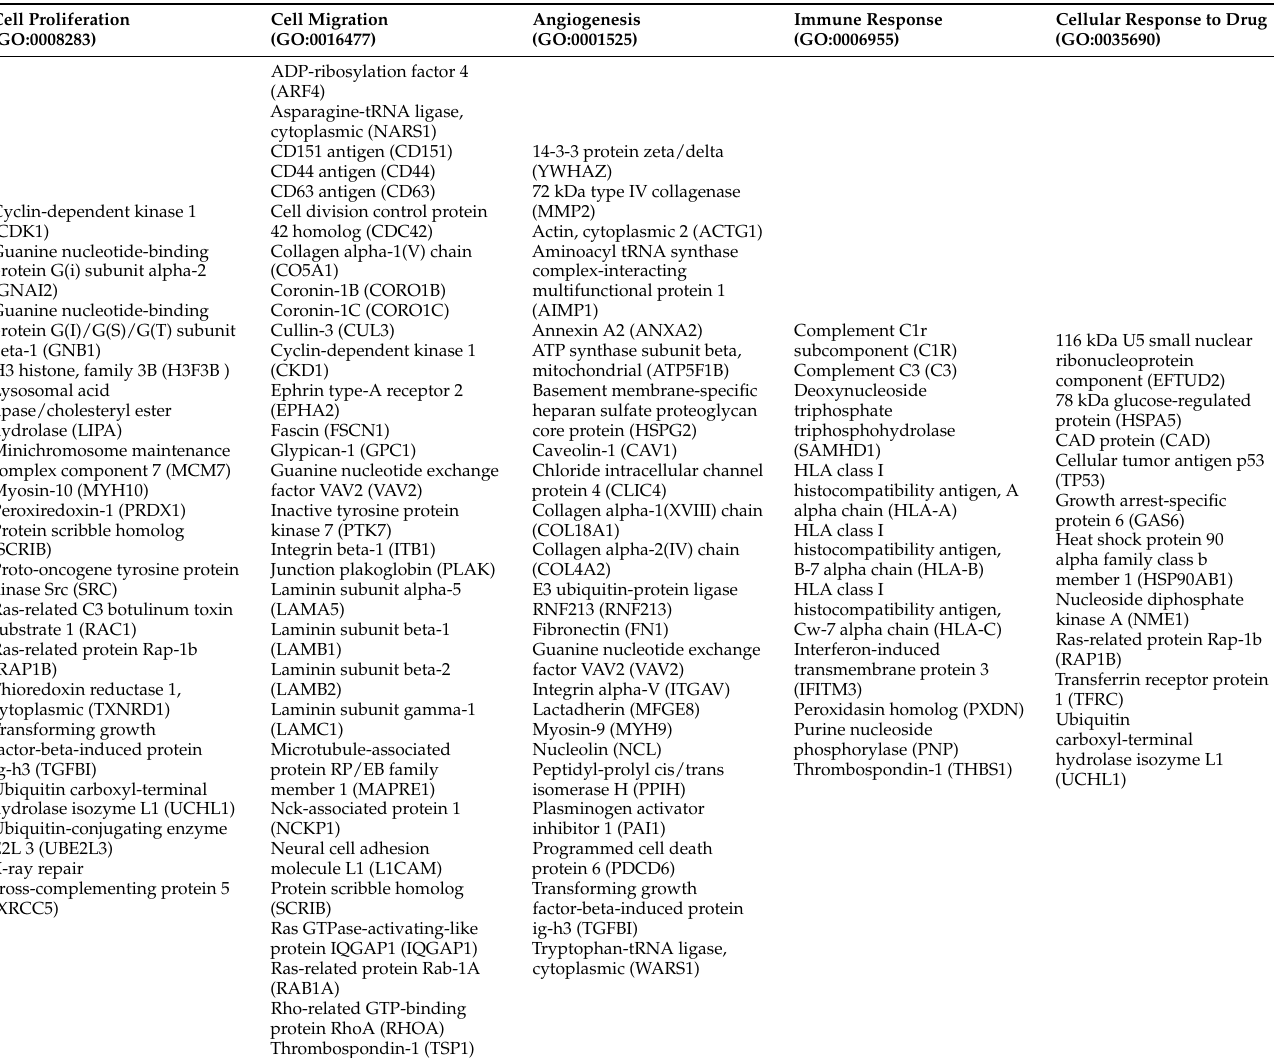
Table 1. Functional classification of cancer-related proteins identified in ectosomes derived from 8305C human thyroid anaplastic carcinoma